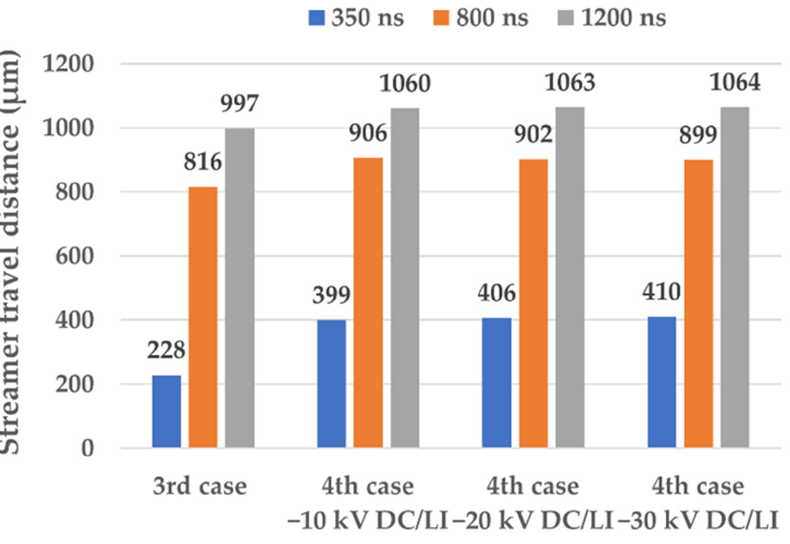
Figure 19. Streamer travel distance ( μ m) at three instants in the 3rd and 4th cases.